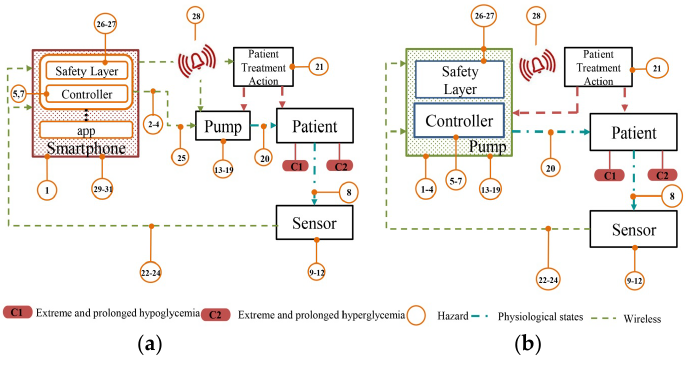
Figure 6. Potential hazards in the AP system: ( a ) controller as a smartphone app; ( b ) controller embedded in the pump. Table 5. Foreseeable hazards in the AP system.